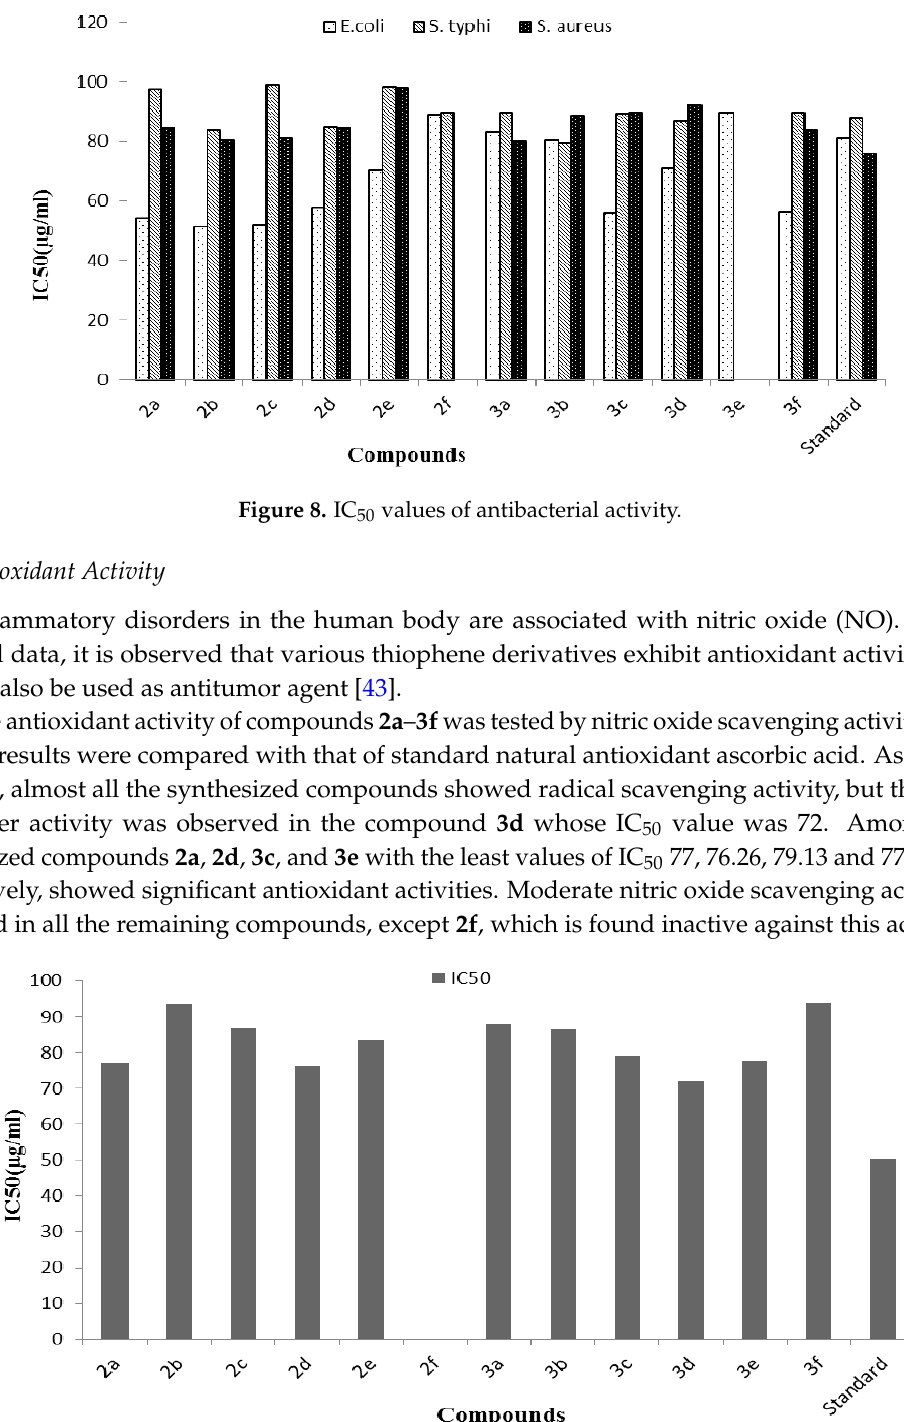
Figure 9. IC 50 values of nitric oxide scavenging activity.